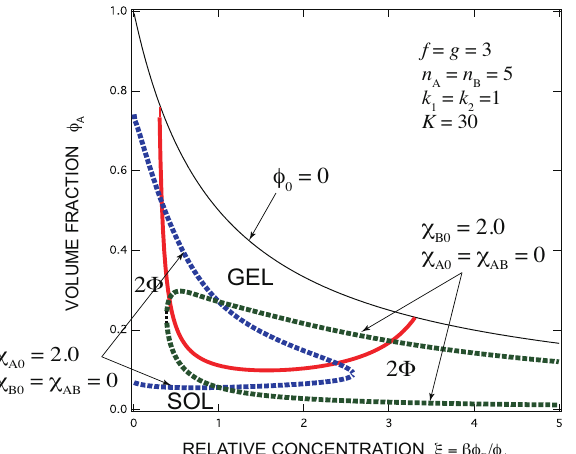
Figure 4. The same as Figure 3a but the interaction parameters are changed: (blue broken line) χ A ,0 = 2.0, χ A , B = χ B ,0 = 0, (green broken line) χ B ,0 = 2.0, χ A , B = χ A ,0 = 0. In the former case, the solution starts from a two-phase state, whose region shrinks with increase in the concentration of B molecules (good solvent for B), and eventually merges into one phase. Turbid gel turns into clear one with increase in B concentration. The latter case shows an opposite tendency; from clear gel to turbid